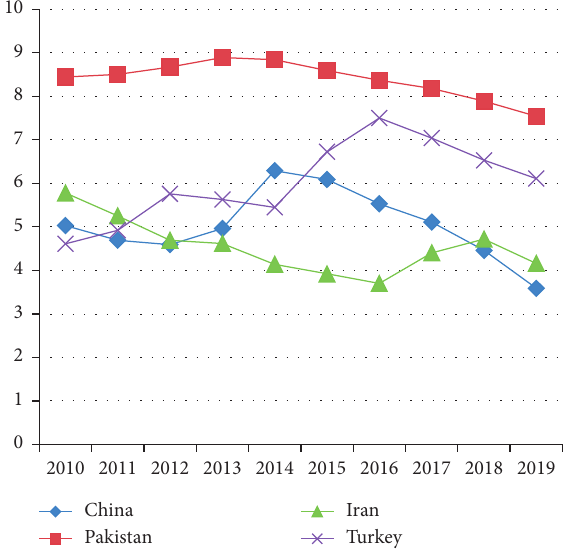
Figure 8: Global terrorism index of four countries from 2010 to 2019. Source: https://www.visionofhumanity.org/maps/global- terrorism-index/#/ (GTI).